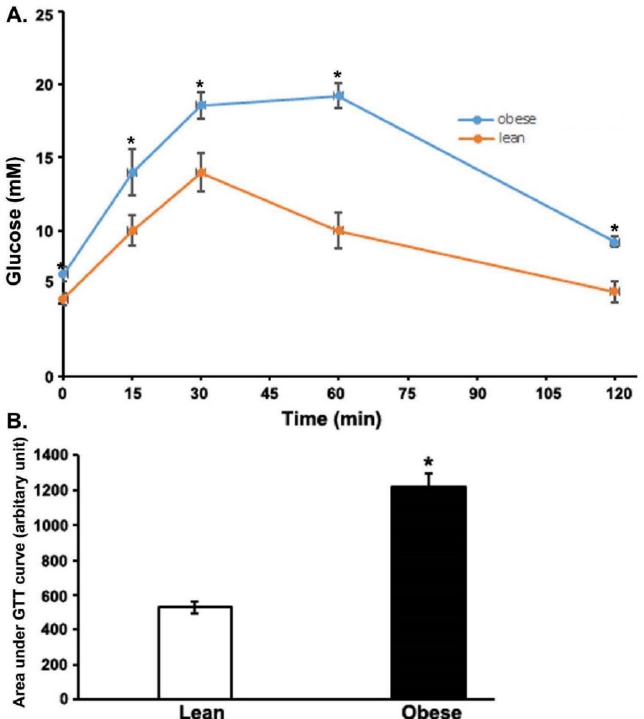
Figure 1. Glucose tolerance test (GTT). At time 0, rats were subjected to glucose (1.5 g/kg IP). ( A ). Blood glucose levels were determined at the indicated time points using a OneTouch Ultra glucometer (LifeScan, Milpitas, CA, USA) and ( B ). The area under the curve (AUC) was calculated using GraphPad PRISM software. * p < 0.01. In each group, six rats were used for GTT analyses.